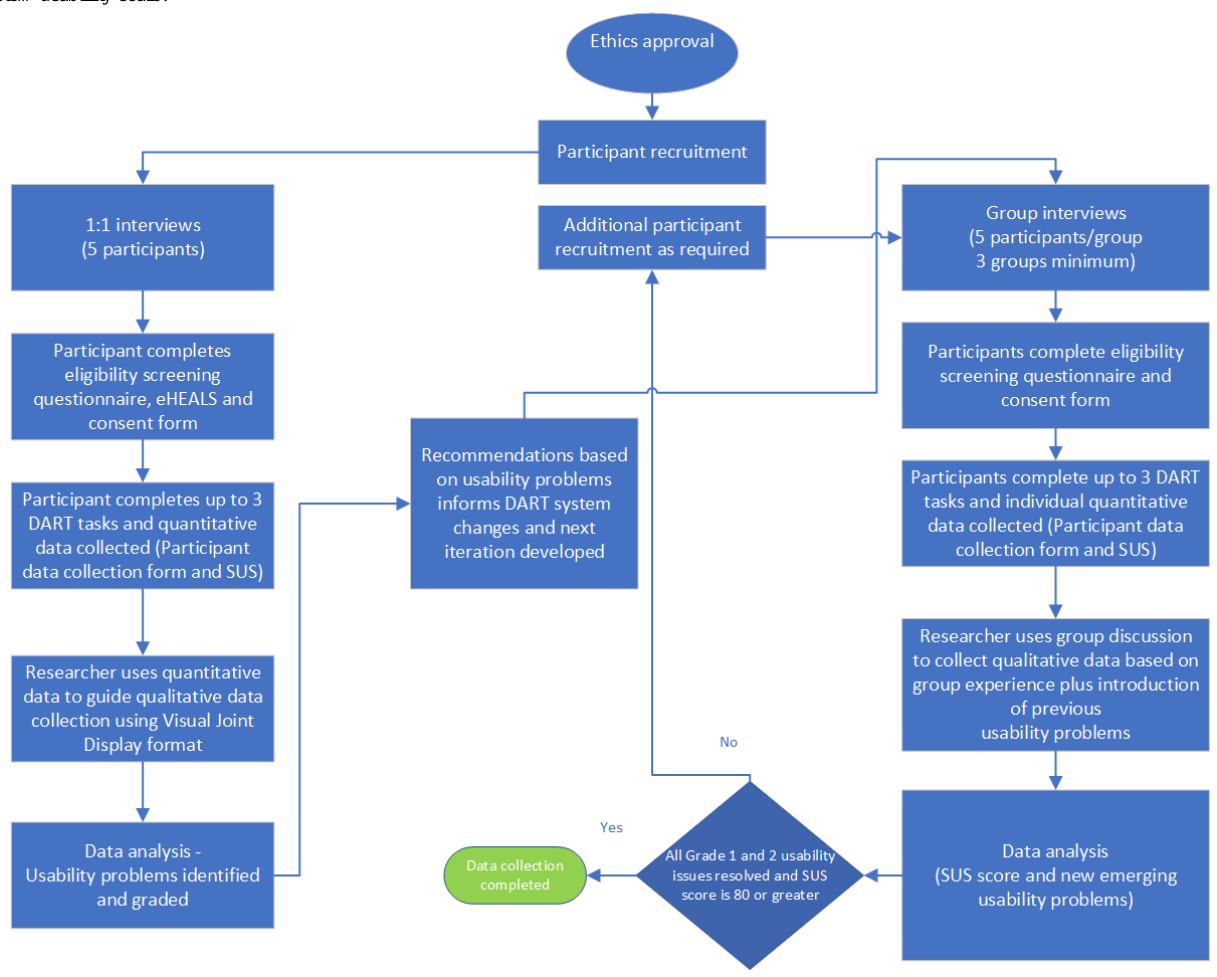
Figure 3. Digital Assessment Routing Tool usability study iterative convergent mixed methods design. DART: Digital Assessment Routing Tool; SUS: system usability